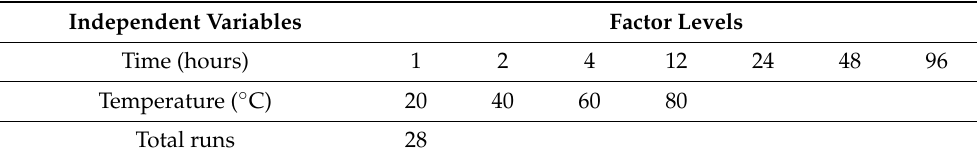
Table 1. Independent variables used for the RSM model set. Independent